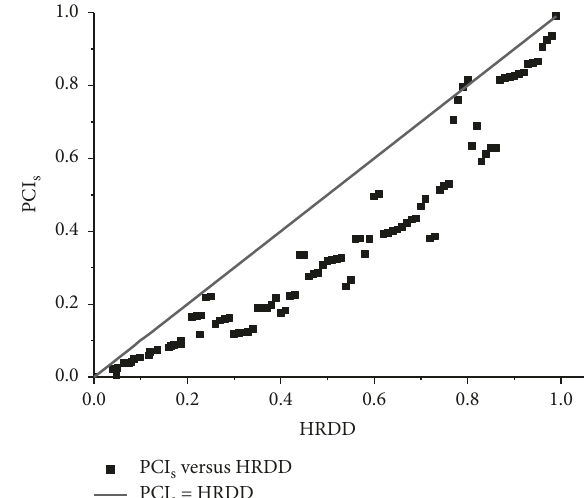
Figure 12: Corresponding relationship between HRDD and PCI